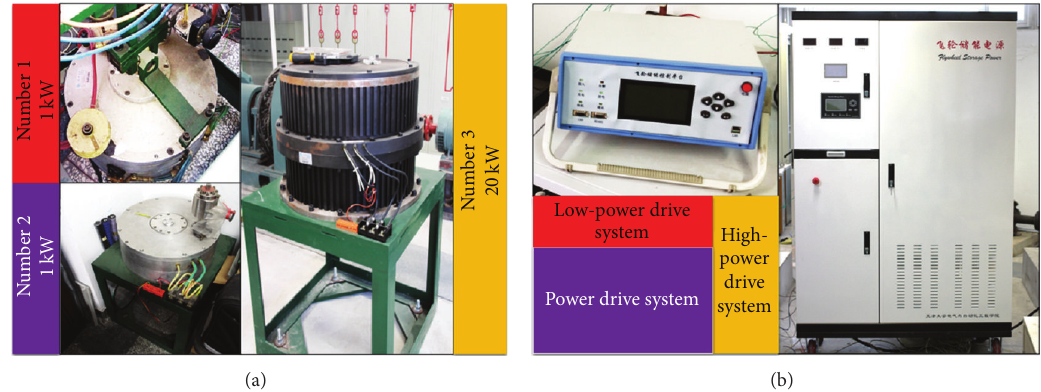
Figure 1: FESS test bench. (a) Flywheel motor system, (b) power drive system. while SP indicates variables may behave in large amplitude